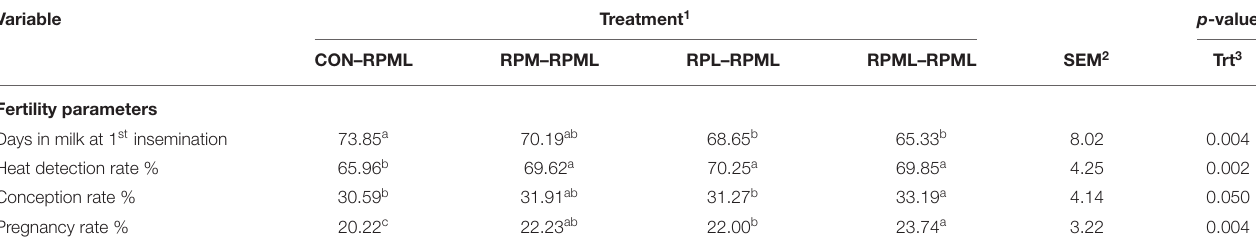
TABLE 6 | Feeding ruminally protected Met and Lys to transition dairy cows and its subsequent effect on fertility. Variable Treatment 1 p -value CON–RPML RPM–RPML